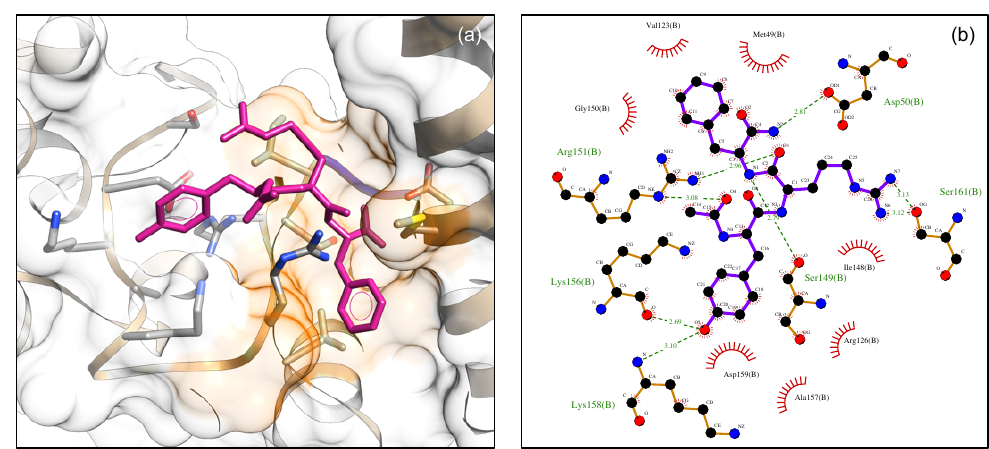
Figure 9. ( a ) Surface model of DTP3 docked to BP4 cavity (orange) where the protein molecule is shown as surface and DTP3 is shown in stick (magenta); ( b ) Interactions of the MKK-KD residues with DTP3 are displayed in a two dimensional model. The main interactions between the protein and the ligands are shown as dotted lines, hydrogen bonds are in green, while the hydrophobic interactions are shown in